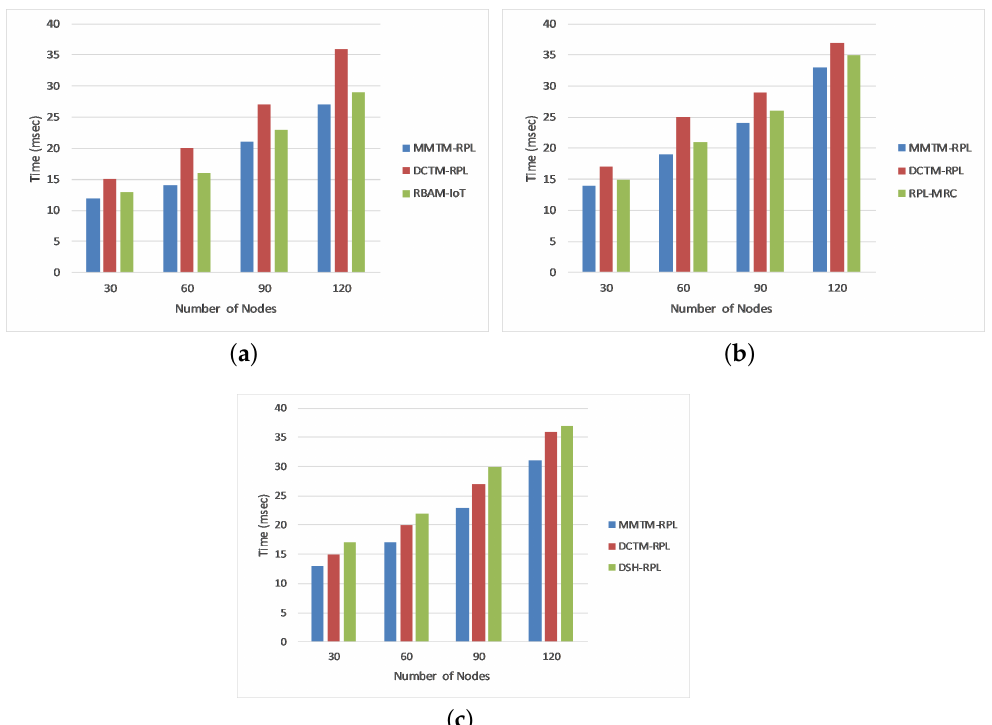
Figure 8. Comparison of attack detection time for different attacks: ( a ) Rank attack, ( b ) Sybil attack, and ( c ) Sinkhole